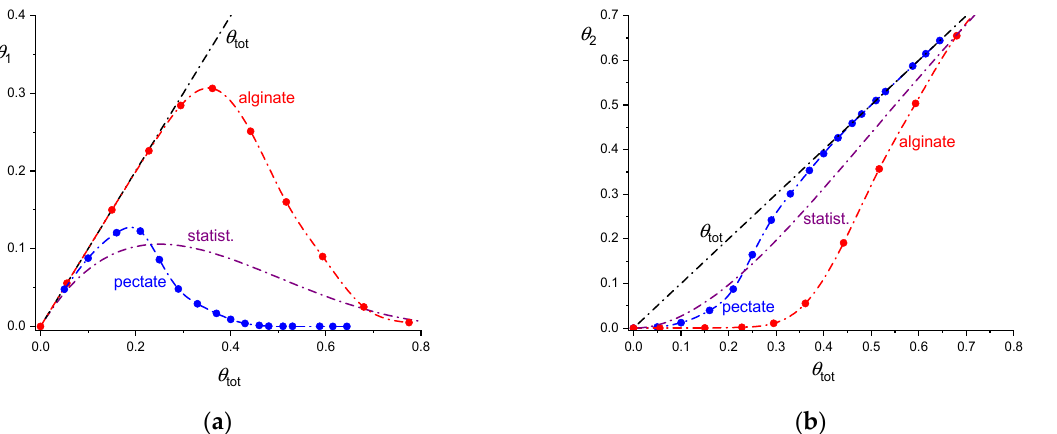
Figure 5. ( a )—Theta 1. ( b )—Theta 2. Dependence on the total fraction of chemically bound calcium ions ( θ tot ) of the fractions of bound ions of type-1 (panel ( a )) and of type-2 (panel ( b )), for pectate (blue filled circles) and alginate (red filled circles); the curves have been drawn to guide the eye. The purple curves represent the dependence on θ tot of θ 1 (panel ( a )) and θ 2 (panel ( b )) calculated assuming a purely statistical filling up of sites with no interaction among nearest-neighboring sites (Equation (15)).